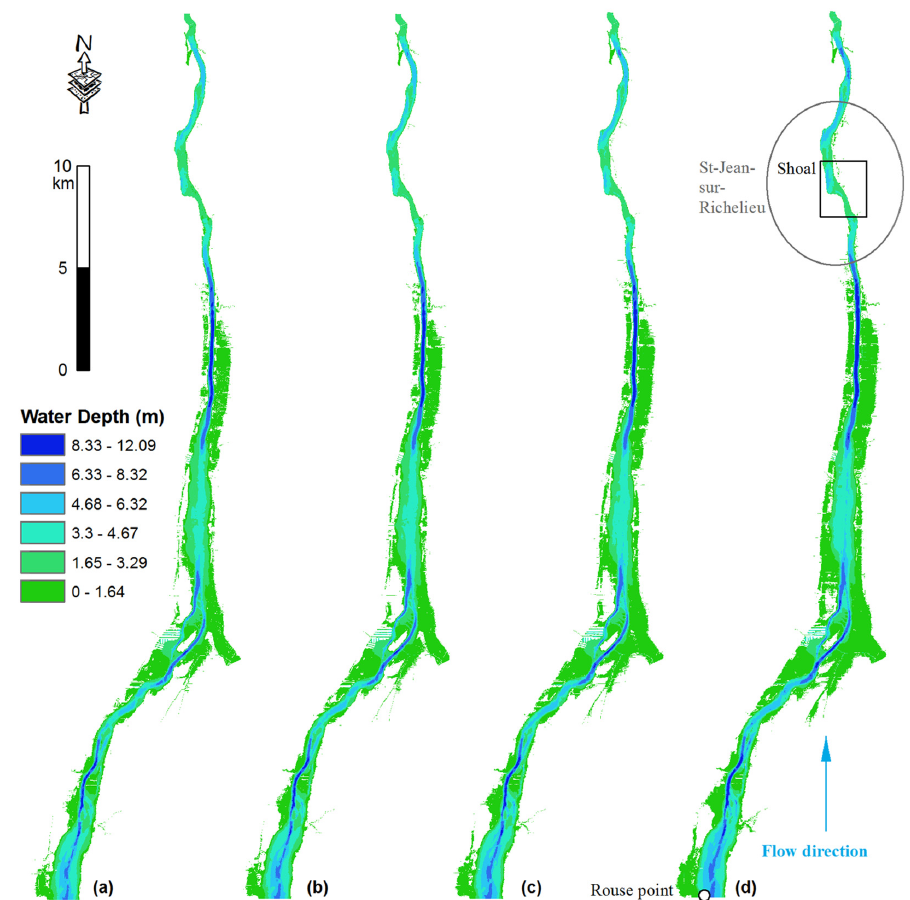
Figure 7 . Mean values of the water depths predicted with the point estimate method for four flow rates: ( a ) 759 m 3 /s ; ( b ) 824 m 3 /s ; ( c ) 936 m 3 /s ; and ( d ) 1113 m 3